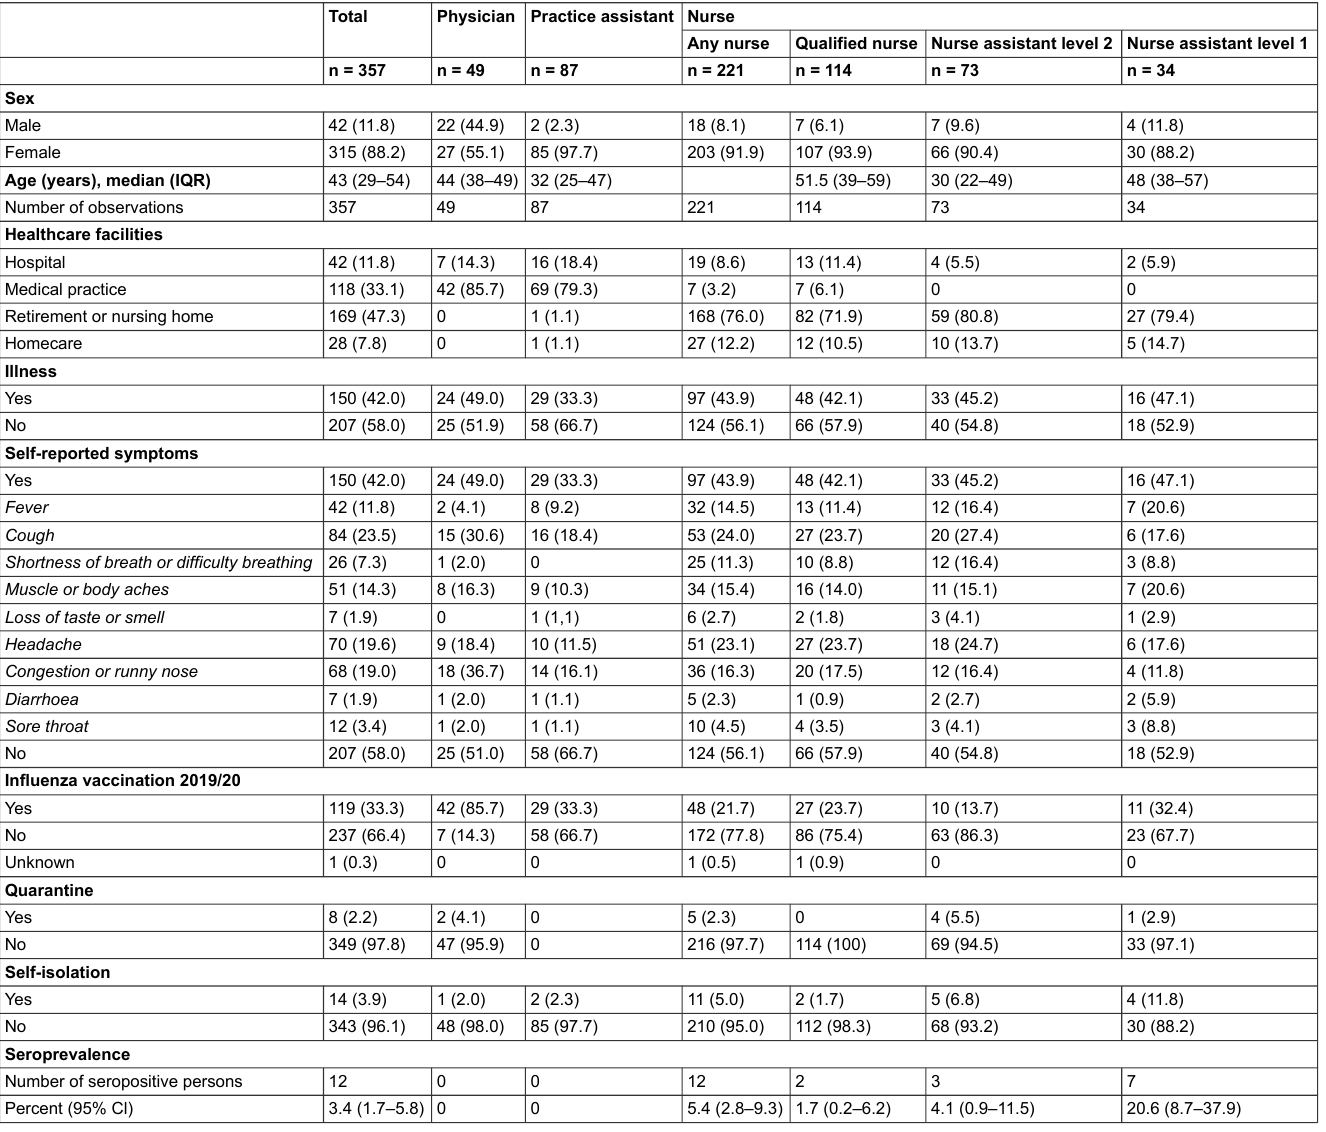
Table 1: Characteristics of study participants by profession (n =